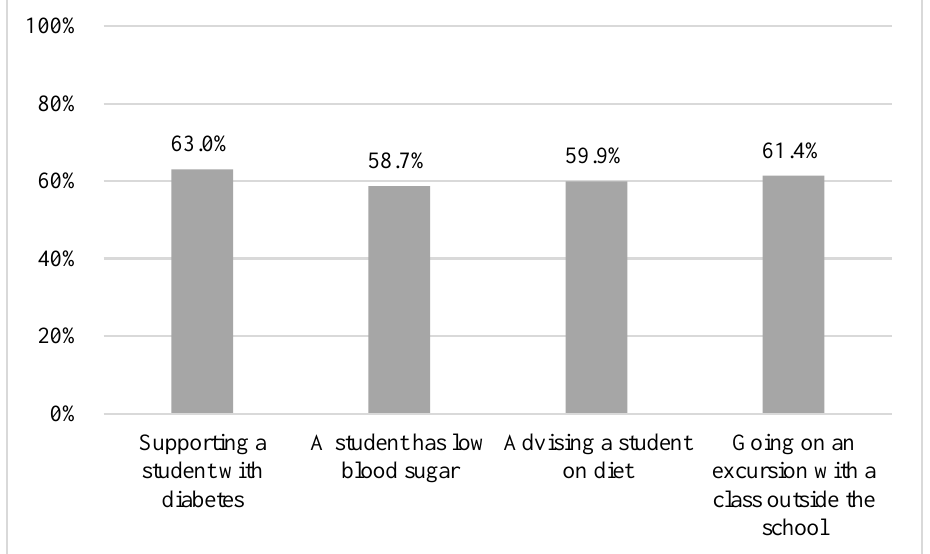
Figure 8. Proportion of participants not feeling unsafe.